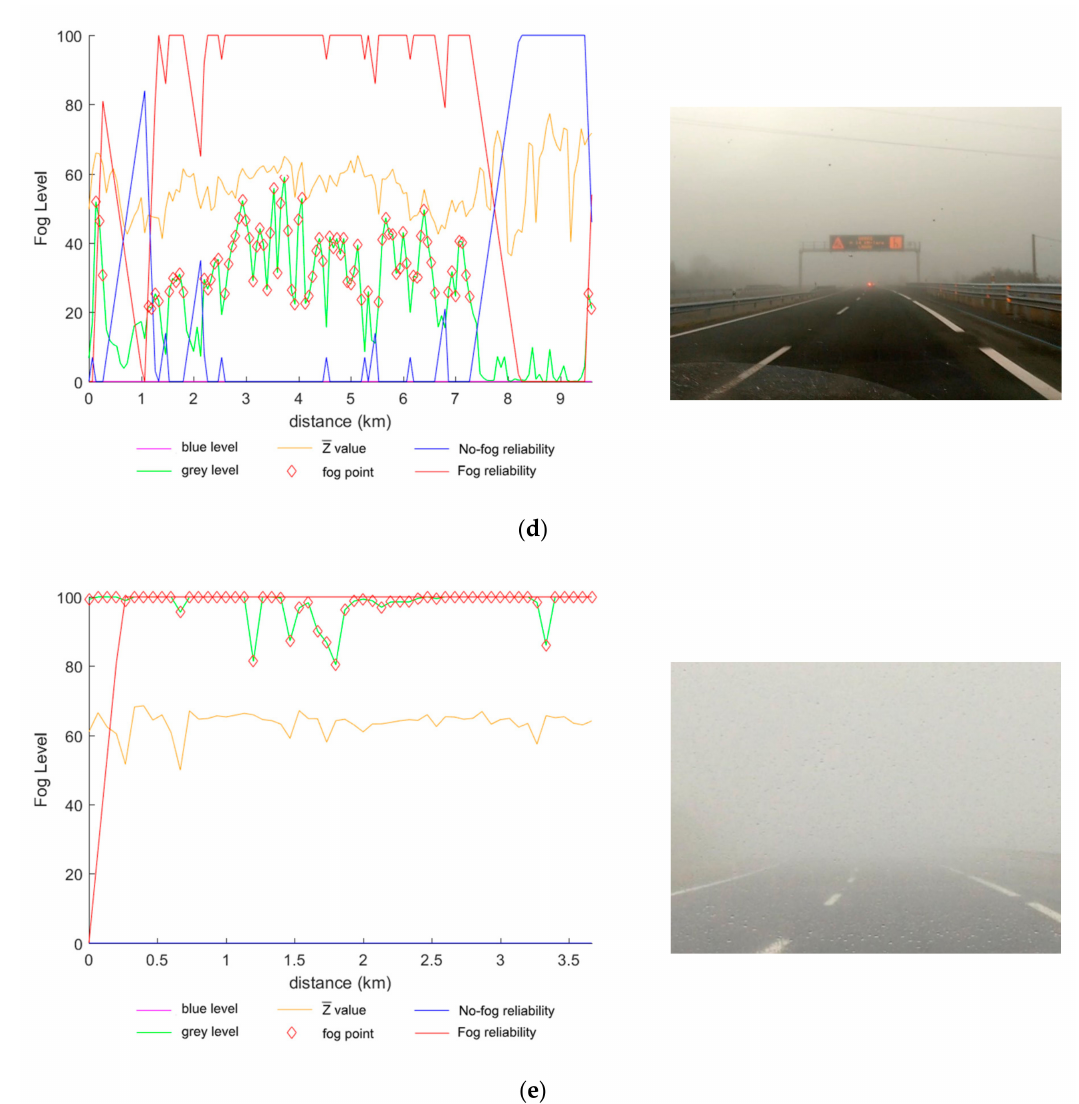
Figure 8. Extended offline analysis of five different videos. Each set of images presents a specific condi-tion: ( a ) sunny; ( b ) cloudy; ( c ) light-fog; ( d ) moderate-fog; and ( e )